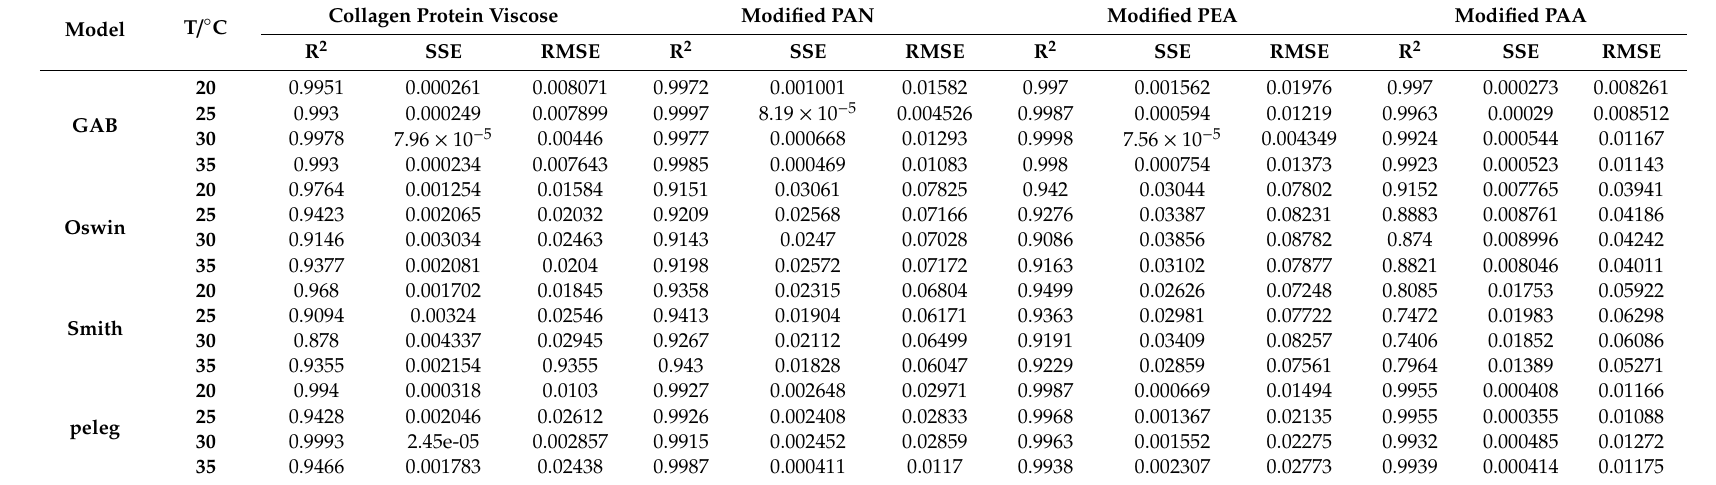
Table 2. Evaluation of di ff erent models for four kinds of hygroscopic exothermic